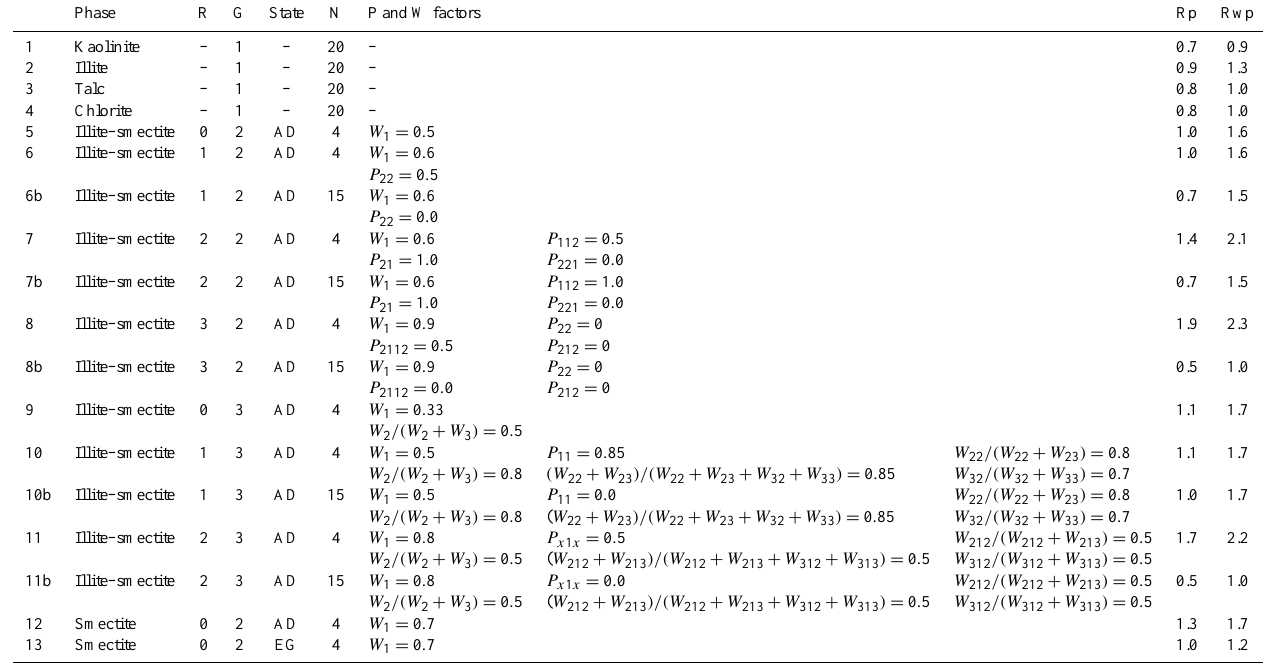
Table 1. Overview of the discrete phases used to compare the output from PyXRD with the output of Sybilla ( R is Reichweite, G is the number of components, N is the average CSDS, AD is air dry, EG is ethylene glycol, relevant probability ( P ) and weight ( W ) factors are given, Rp and Rwp are the unweighted, and weighted residual errors of the patterns